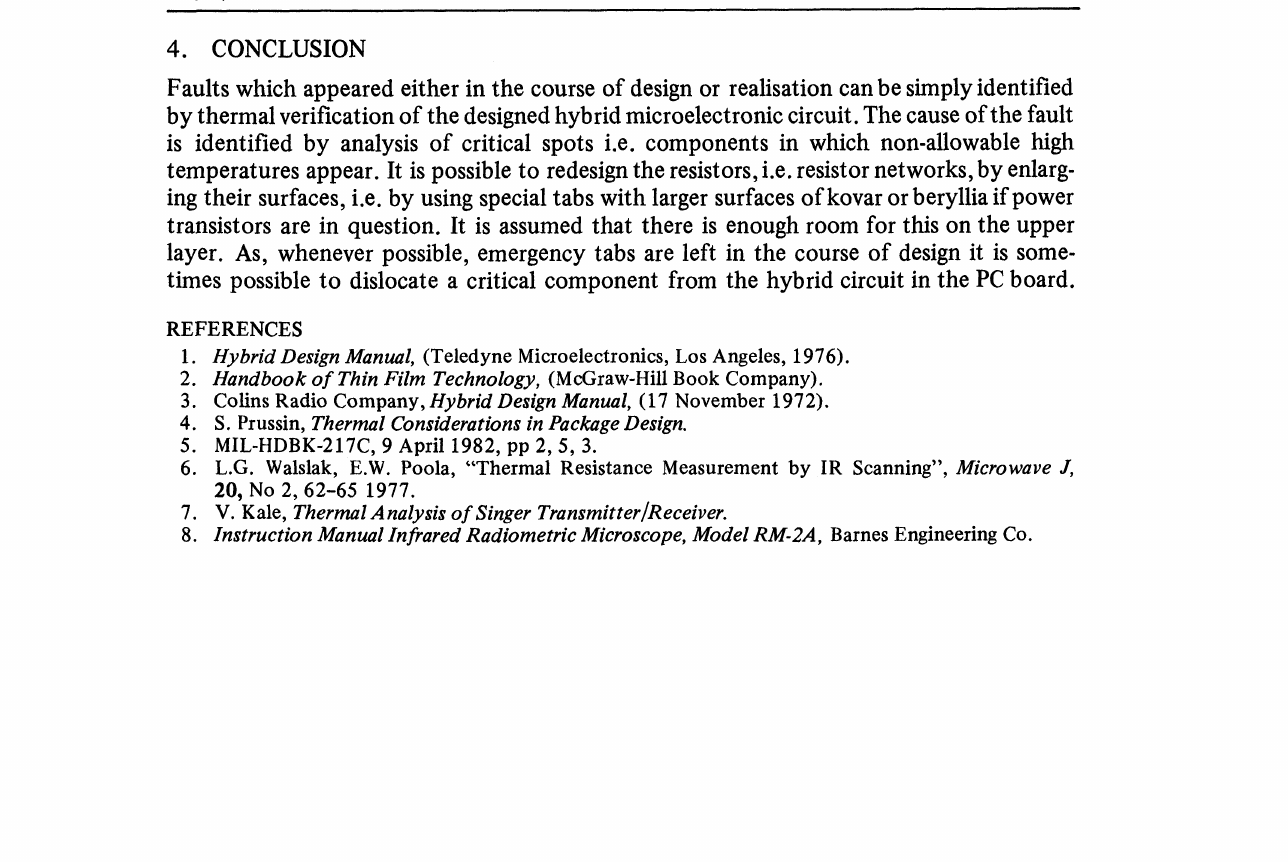
FIGURE 3 Temperature distribution on hybrid cct surface using modred components.